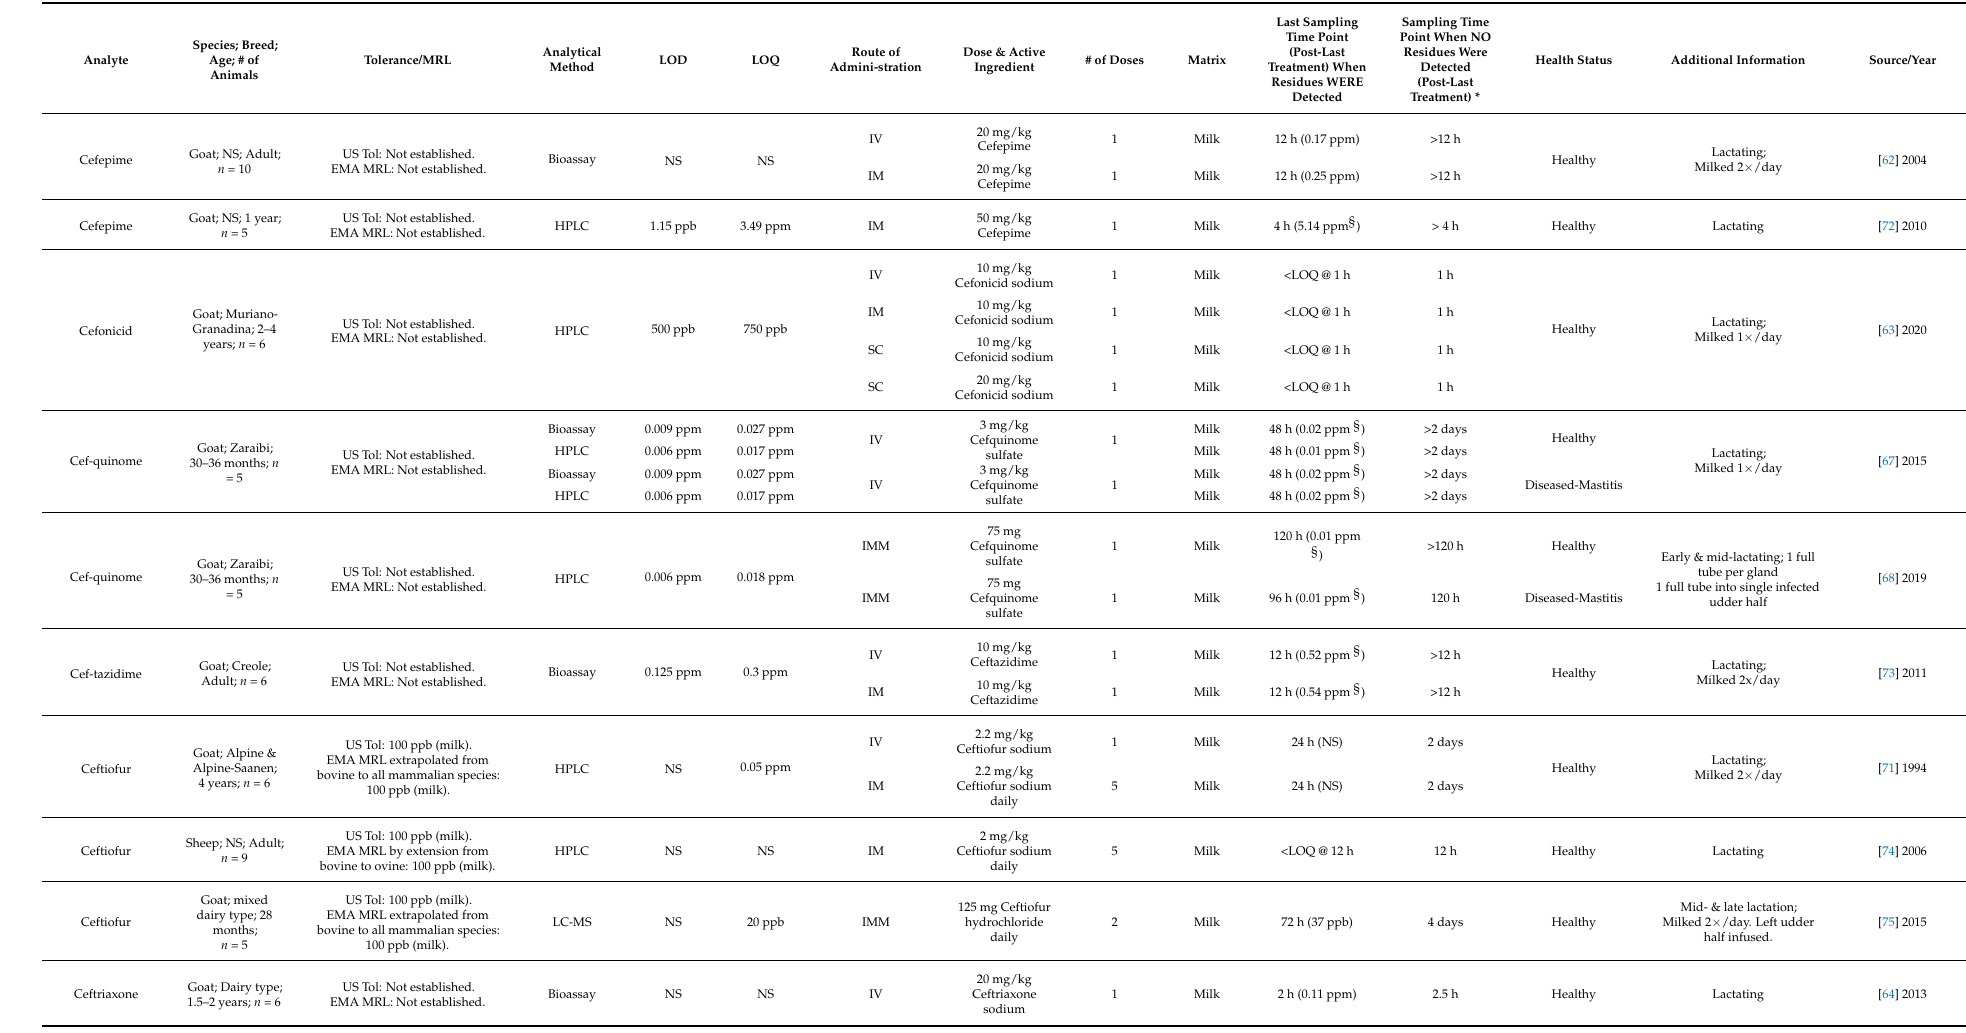
Table 4. Cephalosporin residues in milk or edible tissue samples from sheep or goats following treatment.